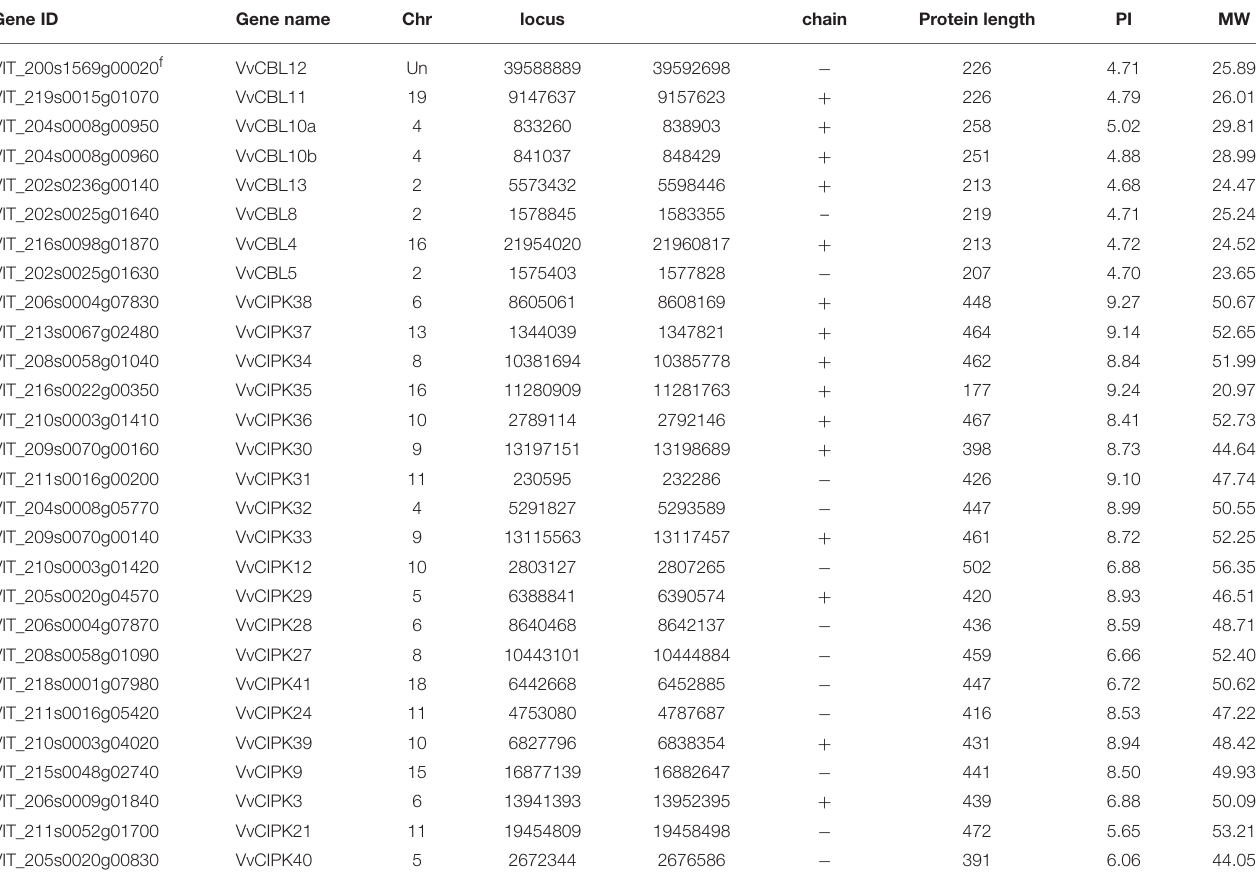
TABLE 1 | Features of CBL and CIPK genes in